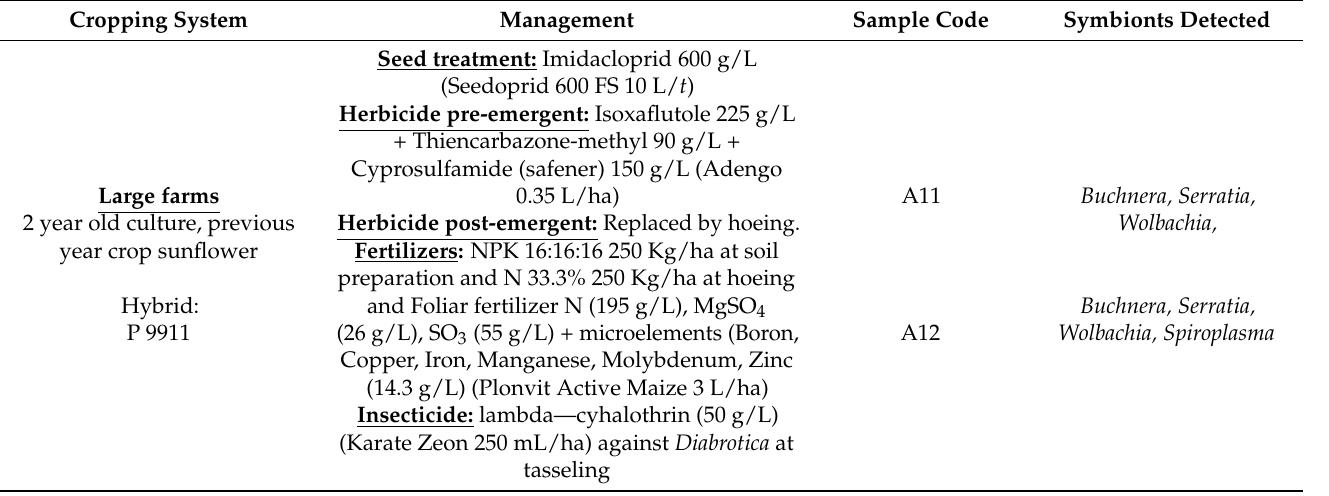
Table 1. Cropping systems and management used in maize fields